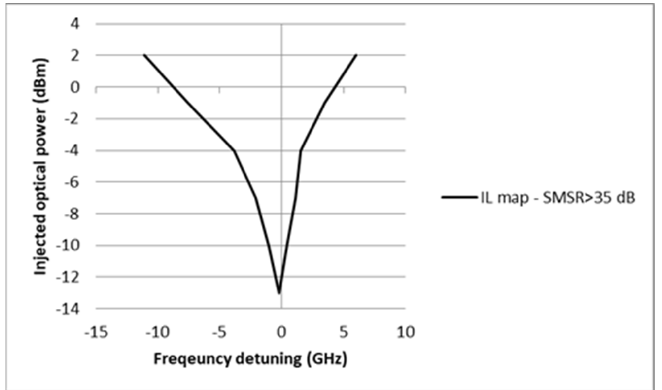
Figure 6. Measured IL map of FP laser for SMSR higher than 35 dB.